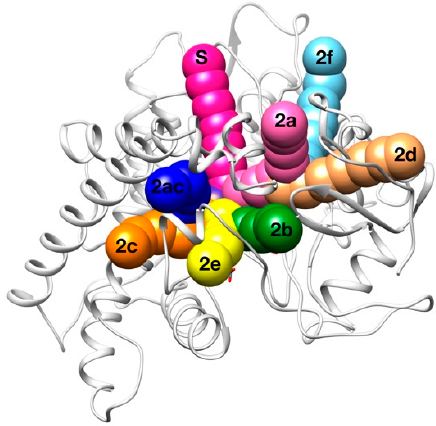
Figure 7. Schematic representation of the binding channels for P450.